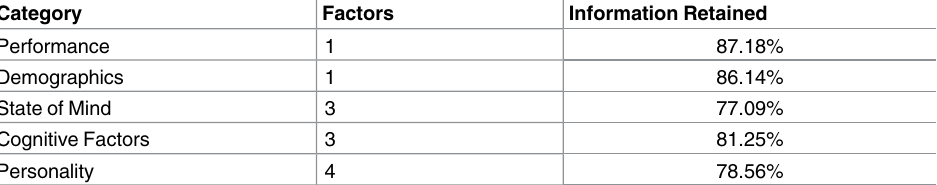
Table 2. Factors common to the multi-task and age-memory trials. Categories, number of factors assignedto each, and how much of the overall variance was retained in each category. Each category repre- sents a subset of the 42 individualdifference measures and the factors represent a percentageof the vari- ance containedin the